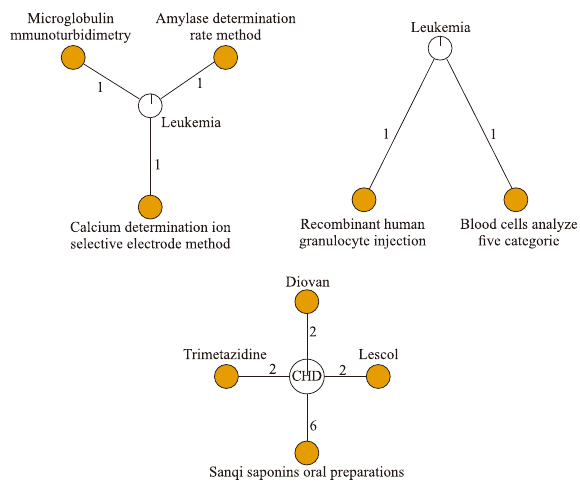
Fig. 6 Mined frequent disease-process subgraph. Although leukemia is a kind of orphan disease, it still appears in the mined frequent disease-process